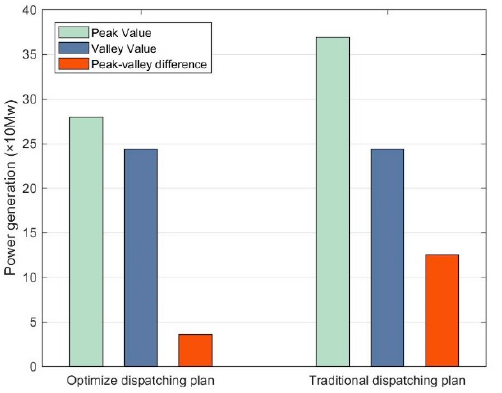
Figure 12. Comparison of joint output volatility under the two schemes.